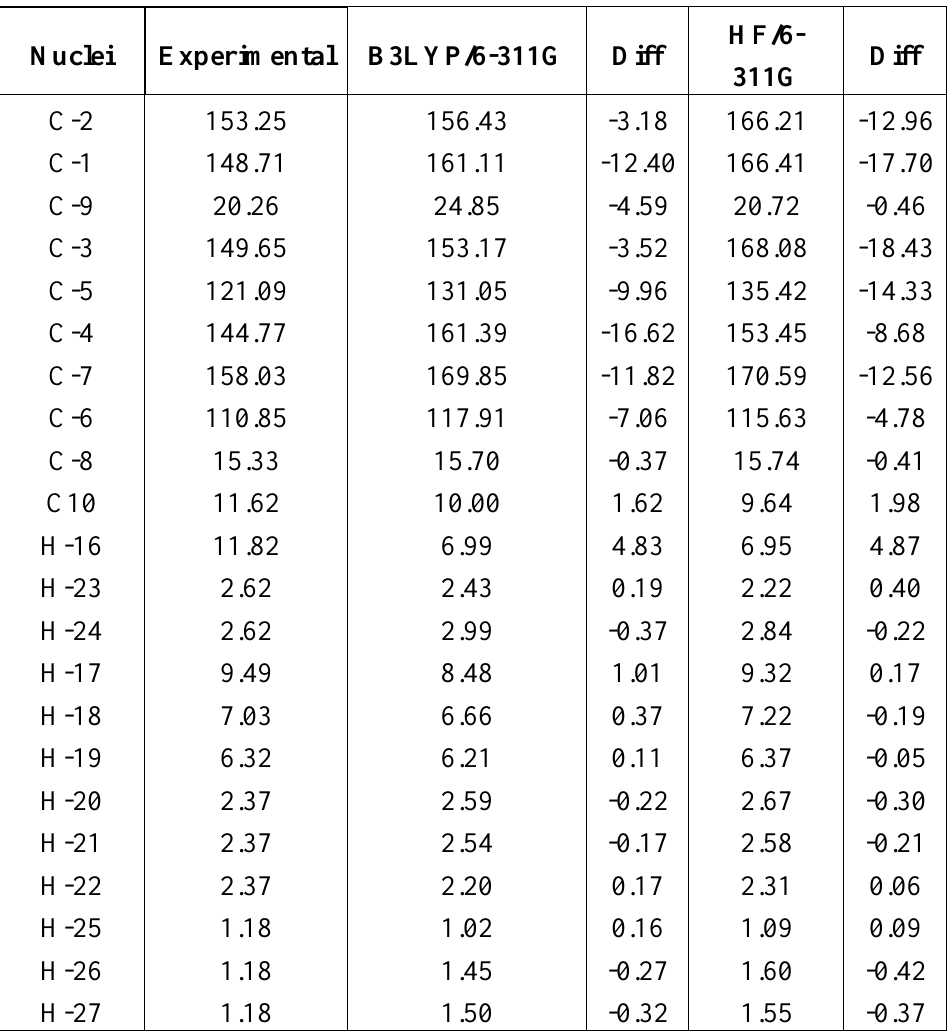
Table 2. Comparision between experimental and calculated chemical shifts (ppm) of 2b .